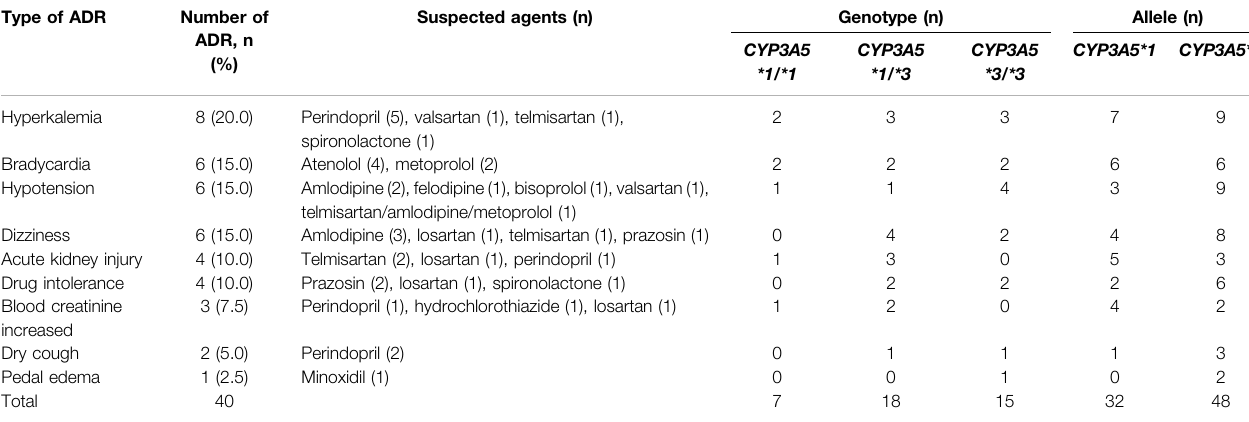
TABLE 2 | Details of antihypertensive-related ADRs reported.